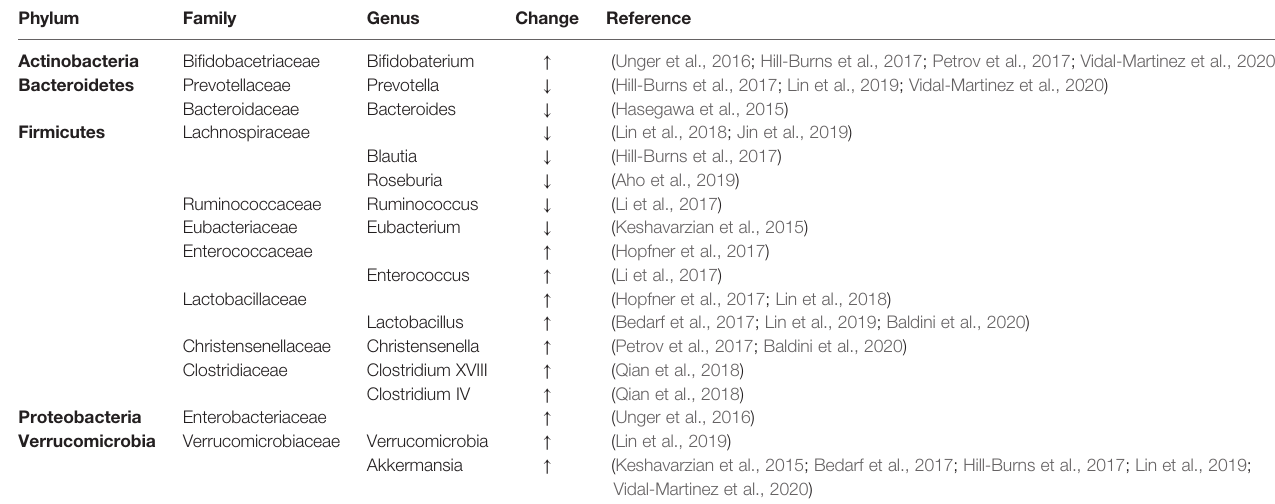
TABLE 1 | Changes in the intestinal microbiota populations of patients of Parkinsons ’ s